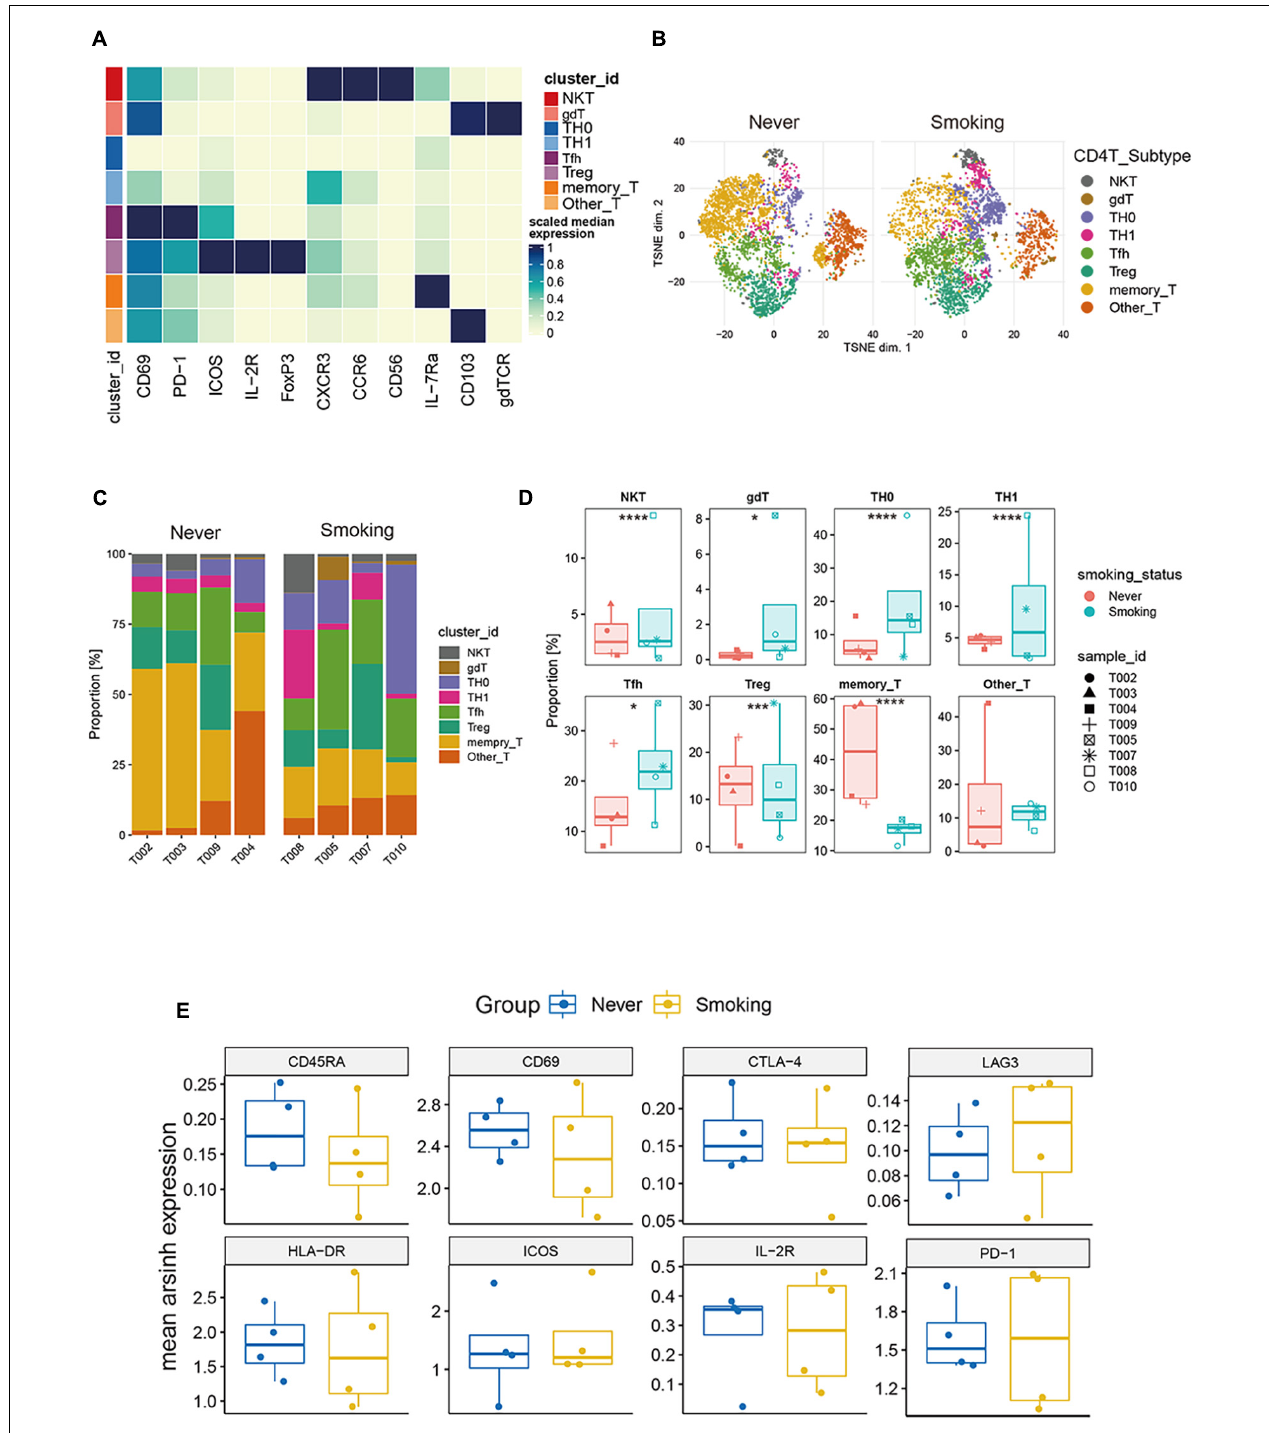
FIGURE 6 | Features of CD4 + T cells in NSCLC with different smoking status. (A) Heatmap of the median marker intensities of the multiple lineage markers in the 8 CD4 + T cell populations obtained by manual merging of the 30 metaclusters generated by FlowSOM. The heat represents the median of arcsinh and 0–1 transformed marker expression calculated over cells from all the samples. (B) t-SNE plot showing the overall distribution of different CD4 + T cell clusters between previous/current smokers and non-smokers. (C) Bar plot showing the relative abundance of different CD4 + T cell types in each sample, faceted by smoking status. (D) Box plot comparing the relative abundance of each CD4 + T cell cluster between different smoking status groups. Box plot center and box correspond to median and IQR, respectively. Different shapes were used to represent each patient. * p < 0.05; ** p < 0.01; *** p < 0.001; **** p < 0.0001; ns, not significant. (E) The expression level of several functional markers in different